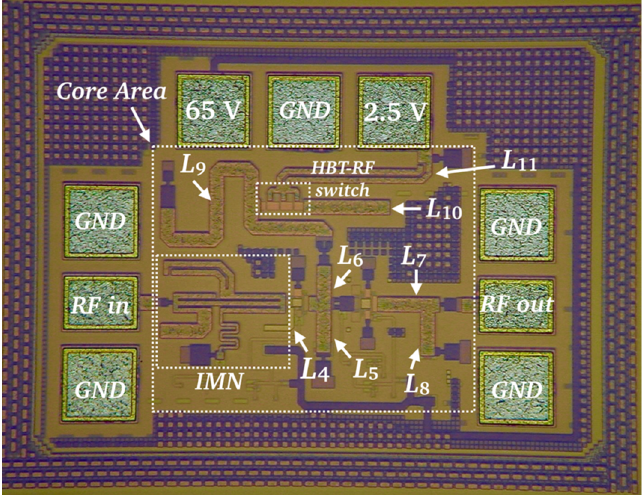
Figure 7. Micrograph of the frequency-switchable LNA including and HBT-RF switch fabricated in a SG13G2 0.13 µm SiGe:C BiCMOS technology from IHP [25]. Dimensions are: A CHIP = 515 µm × 382 µm and A CORE = 331 µm × 274 µm. The HBT-RF switch area is: 45.4 µm × 23.6 µm.